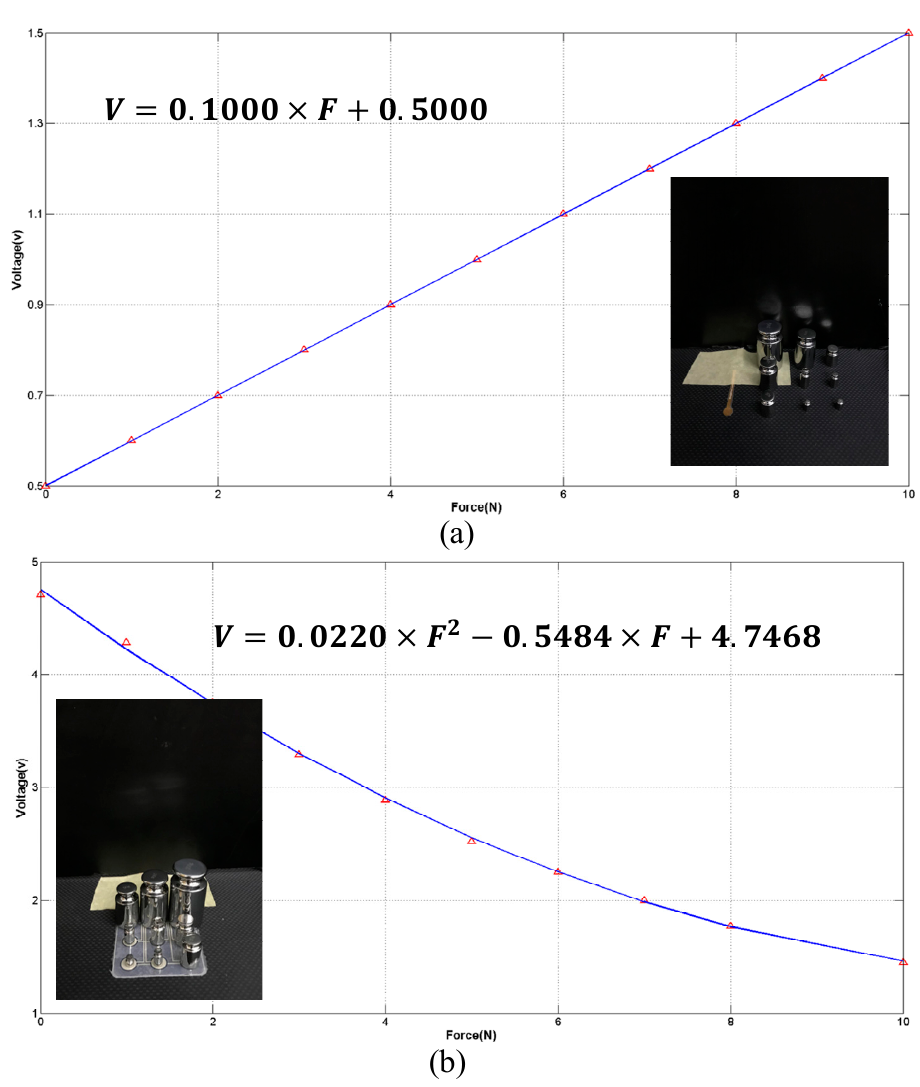
Figure 6. The sensor character of ( a ) CPCS and ( b ) RPCS.